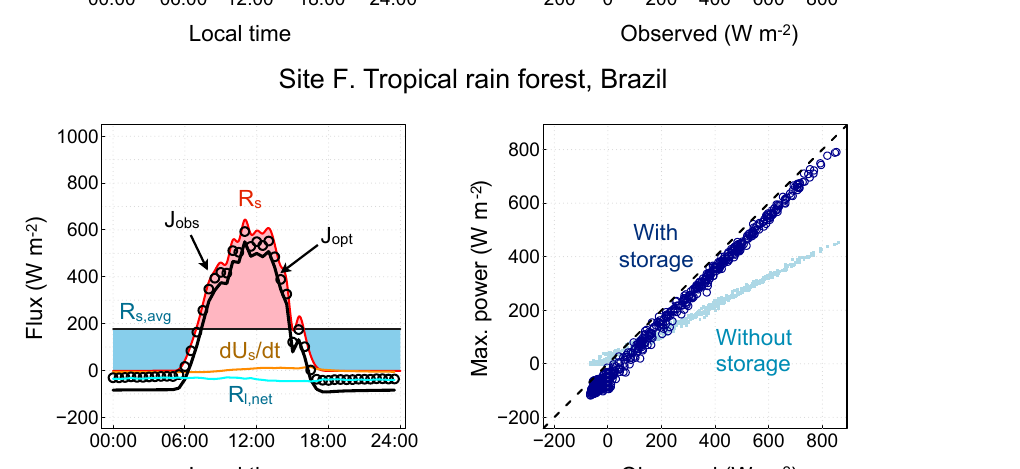
Site F. Tropical rain forest, Brazil